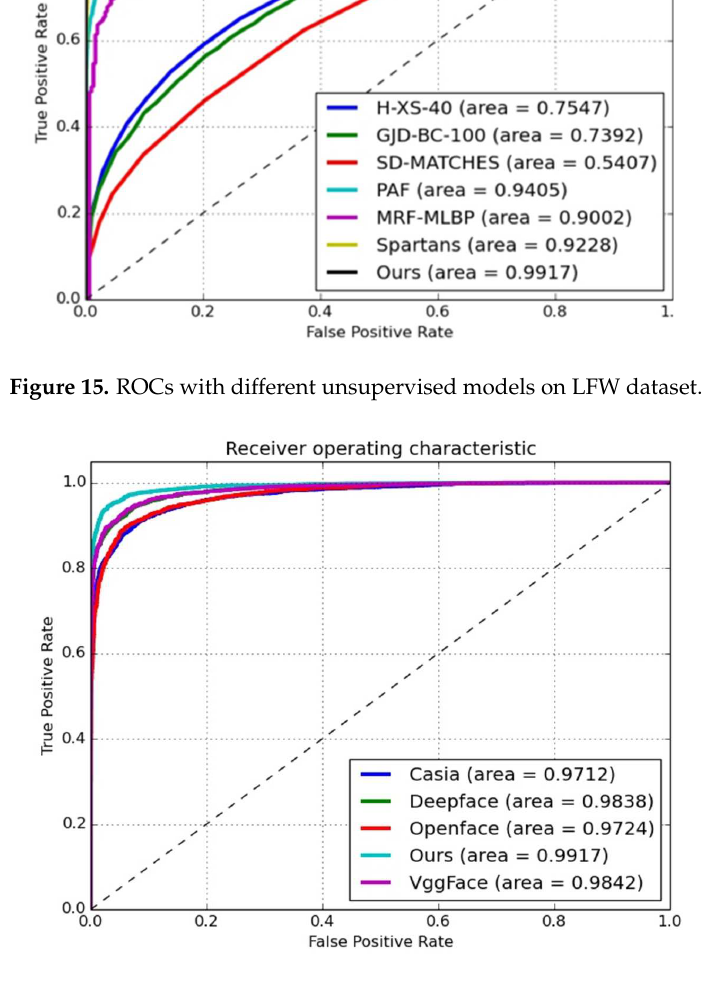
Figure 16. ROCs with unsupervised verification protocol on YTF dataset for some up-to-date